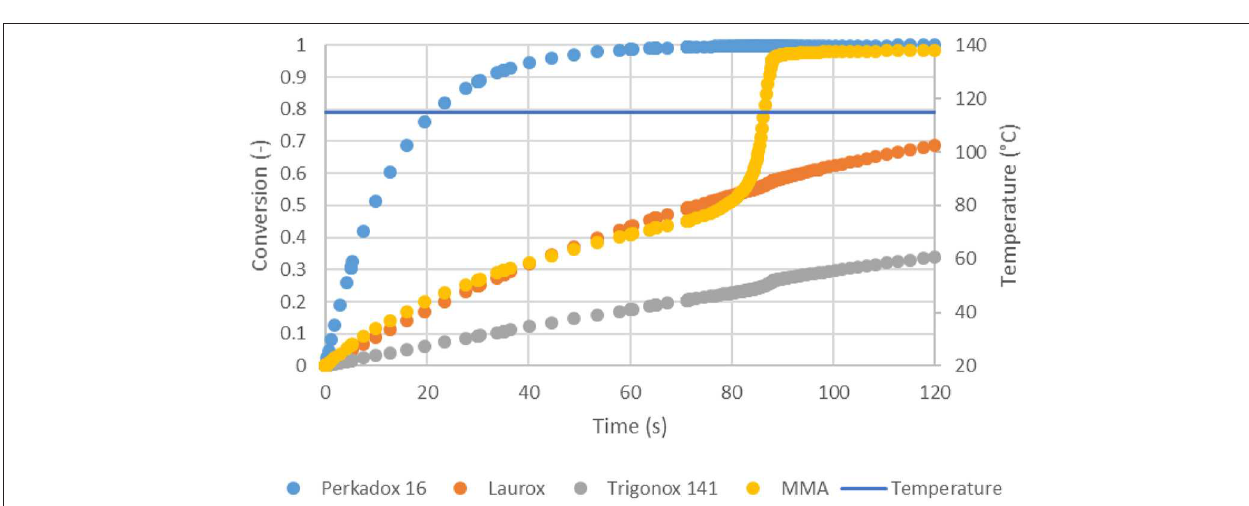
Frontiers in Materials |